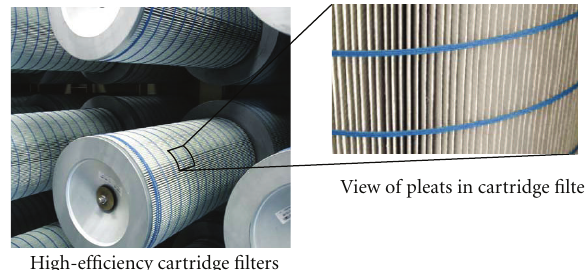
Figure 8: High-e ffi ciency cartridge filters [29].